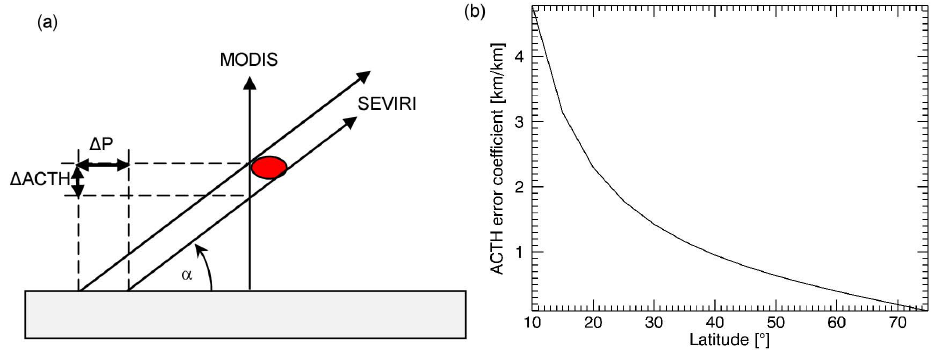
Fig. 10. ACTH error coefficient as a function of the latitude. (a) shows the simplified geometry discussed in the text and (b) the variation of the error with latitude.